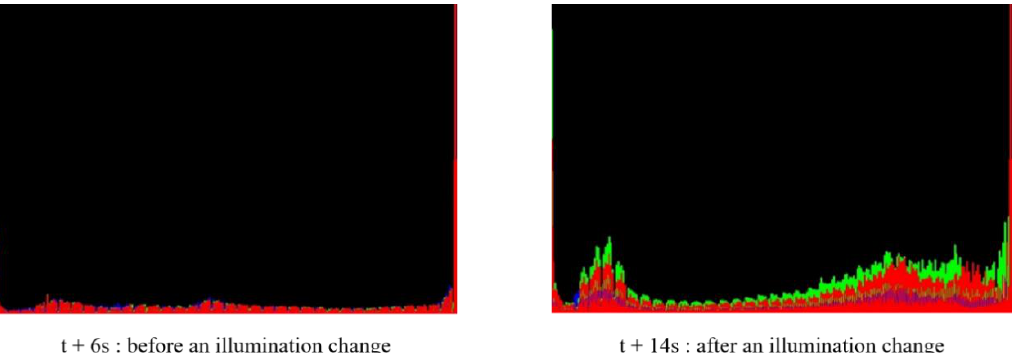
Figure 6. Histogram of the whole video frame image with an illumination change in ABODA video 7.